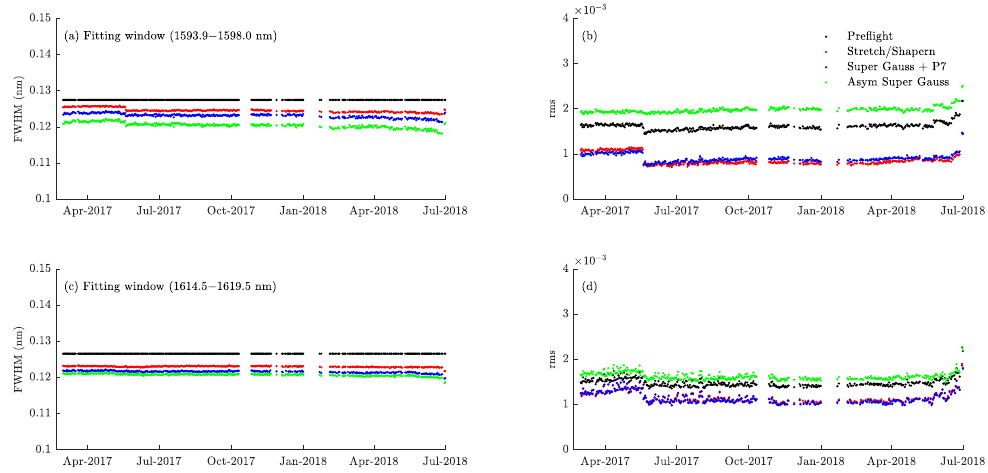
Figure 6. ( a ) FWHM and ( b ) average fitting residual of retrieved ILS using four ILS functions for the WCO2 band at footprint 1 and fitting window 1 over time. ( c , d ) Similar to ( a , b ) but for fitting window 6,